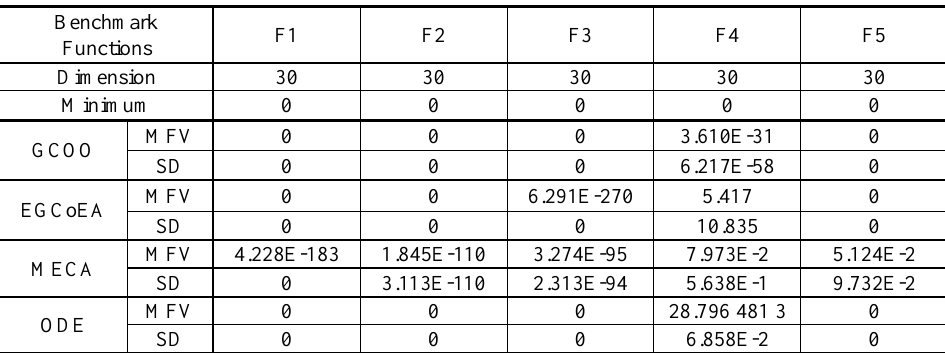
Table 2 Mean Function Values (MFV) and Standard Deviations (SD) of 50 Independently Random Experiments F1~F5 Benchmark